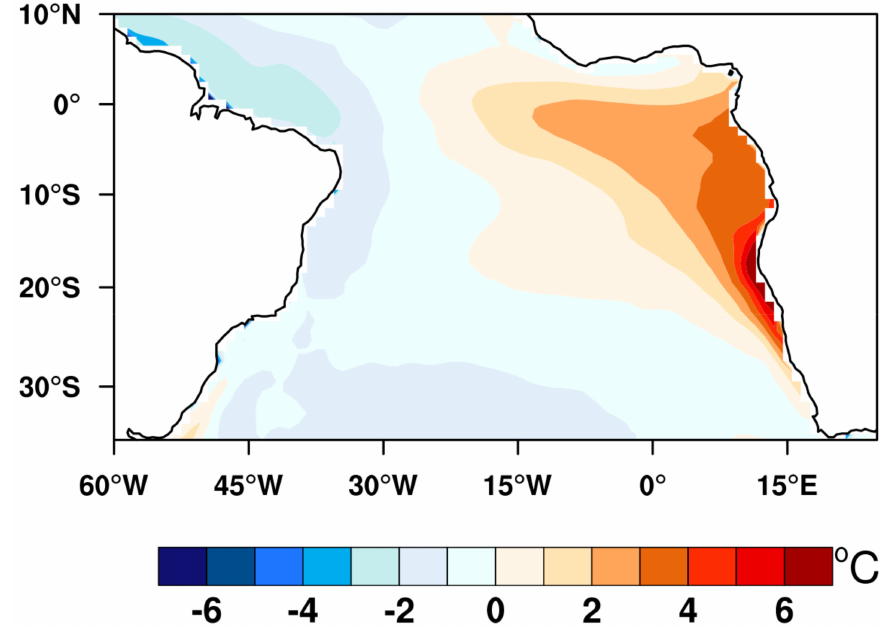
Figure 10. Mean SST bias for the 1988–2007 period in a present time simulation with the coupled global model